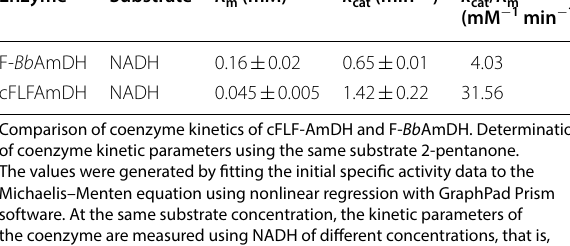
Table 1 Kinetic parameters of the parent for substrate NADH Enzyme